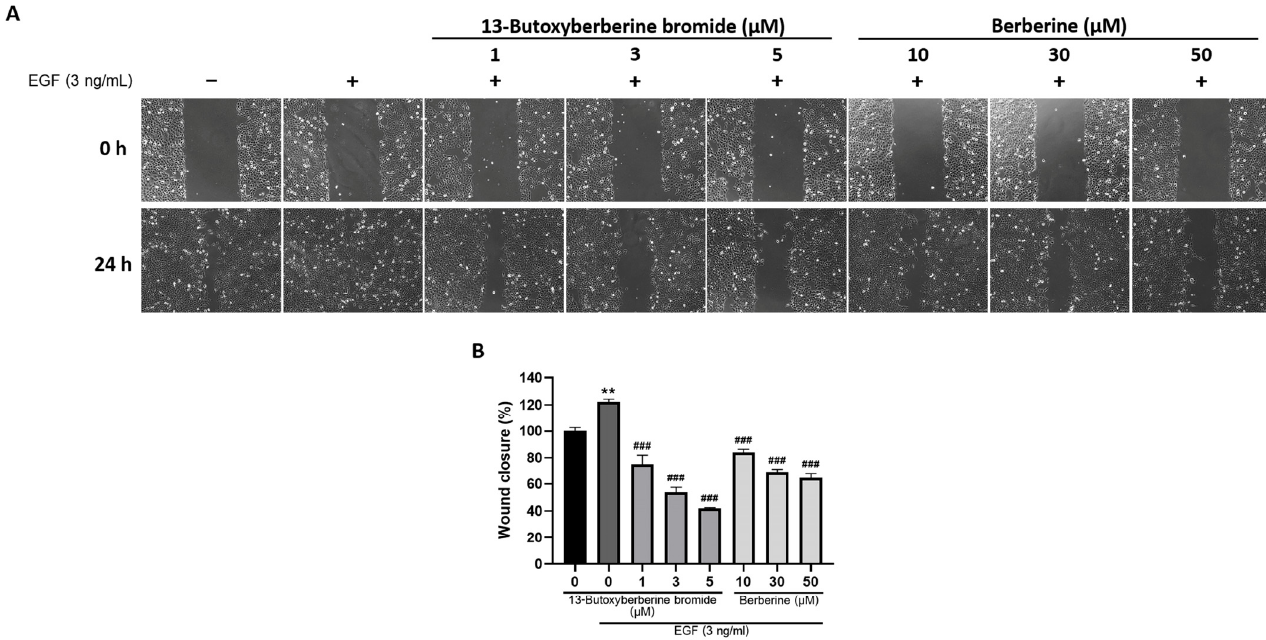
Figure 8. Effect of 13-butoxyberberine bromide and berberine on EGF-induced cell migration in A431 cells. Cells were pretreated with 13-butoxyberberine bromide and berberine for 30 min. Then, cells were induced with EGF before investigating the wound areas. ( A ) The wound distance was observed under an inverted microscope (100× magnification). ( B ) The histogram presents the wound closure percentage after incubation with 13-butoxyberberine bromide and berberine for 24 h. Data were expressed as mean ± SD ( n = 3). ** p < 0.01; significant difference from the control group without EGF stimulation. ### p < 0.001; significant difference from the control group with EGF stimulation.